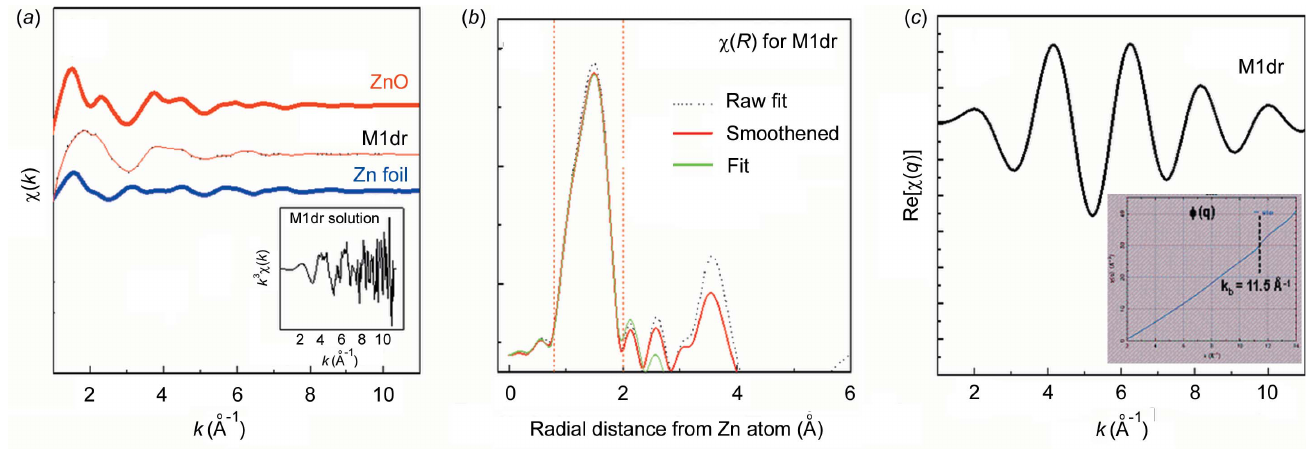
Figure 5 ( a ) Zn K -edge XAFS oscillations (cid:6) ( k ) for Zn foil and ZnO powder standards and for M1dr solution at room temperature, laterally shifted relative to each other for clarity. Raw (black dotted) and smoothened (pink solid) datasets for M1dr are overplotted. Inset: k 3 (cid:6) ( k ) for M1dr highlights noise over the higher k -region. ( b ) Fourier transform of | (cid:6) ( R )| of XAFS data for M1dr, over transform range k = 2.5–10 A˚ (cid:3) 1 . | (cid:6) ( R )| for raw (black dotted) and smoothened (pink solid) data are overplotted. The fit | (cid:6) ( R )| (solid green) is compared. The fit range R = 0.8–2 A˚ is marked by red vertical lines. ( c ) (cid:6) ( q ) = back-transform of (cid:6) ( R ) over the first shell ( R = 0.8–2 A˚ ). A beat-like feature of (cid:6) ( q ) is evident. Inset: ’ ( q ) = phase of (cid:6) ( q ), displaying a jump at k b = 11.5 A˚ (cid:3) 1